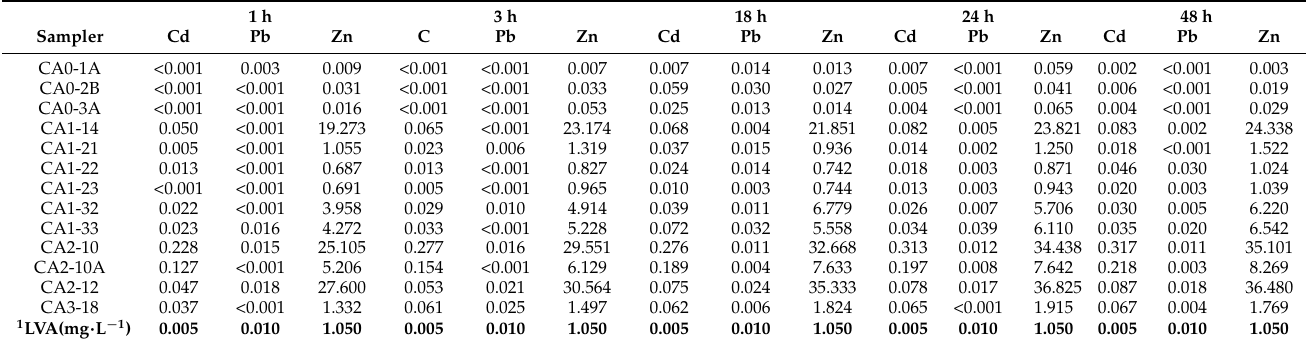
Table 3. Average values (mg · L − 1 ) obtained in the leaching test for the most relevant elements according to the different stirring